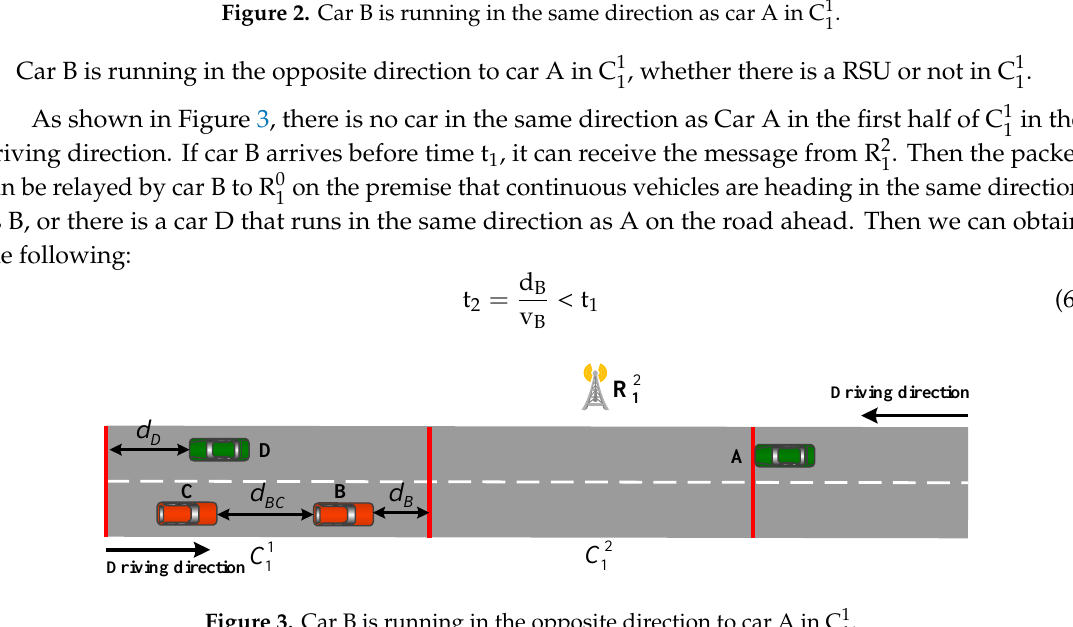
Figure 2. Car B is running in the same direction as car A in C 1